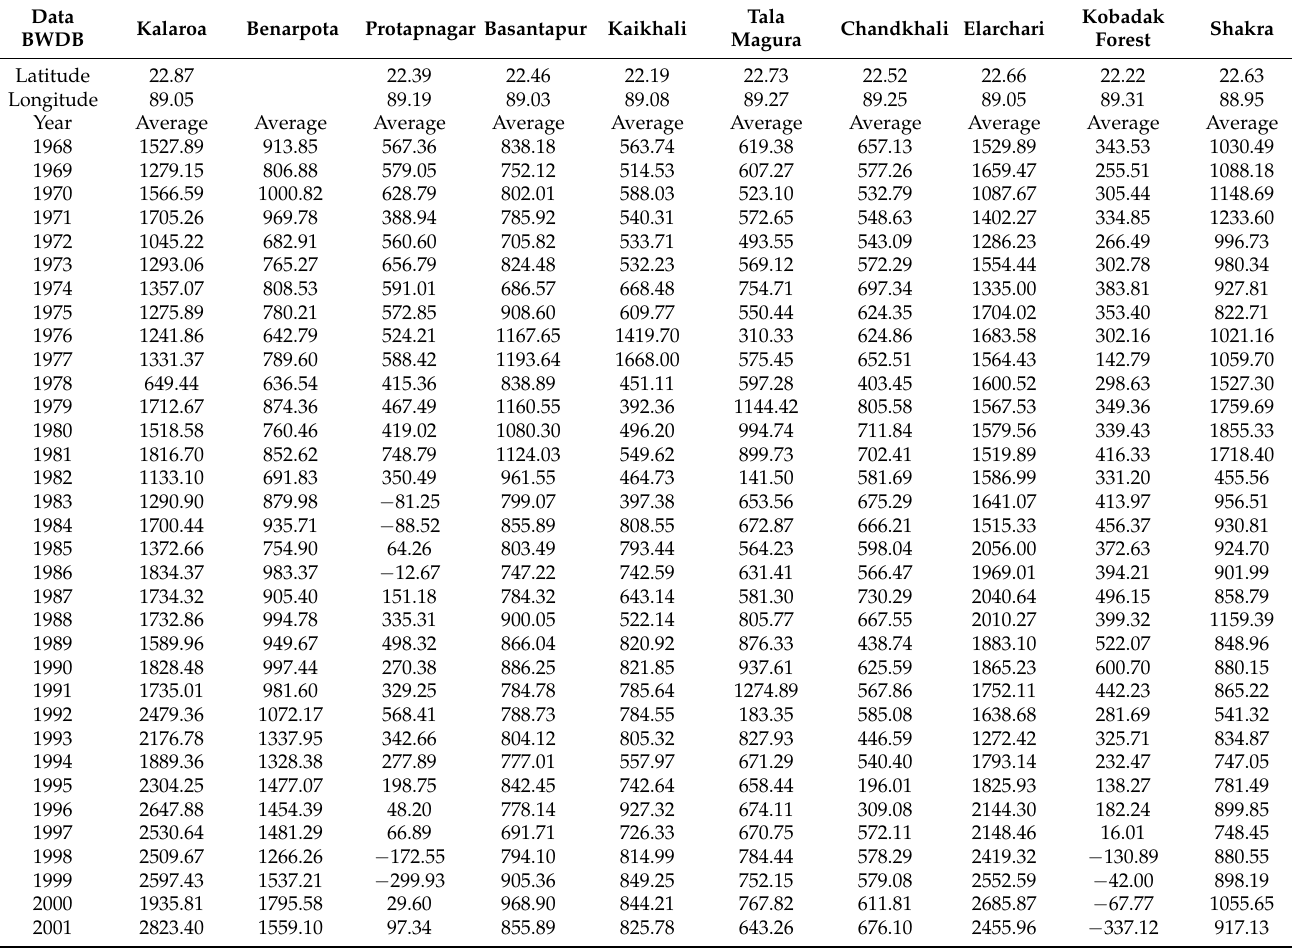
Table 2. Data from 10 tide gauge 10 stations from the Ganges Delta (primary data were collected from the Bangladesh Water Development Board